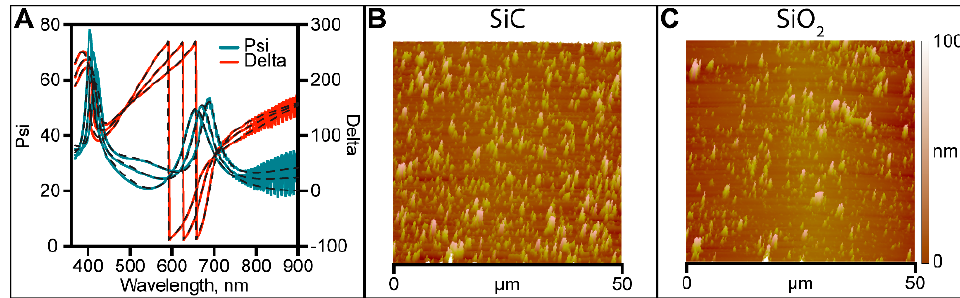
Figure 2. ( A ) Ellipsometric measurement of a-SiC blank sample. ( B ) a-SiC blank sample 50 µm × 50 µm 3D topographic map. ( C ) SiO 2 blank sample 50 µm × 50 µm 3D topographic map.